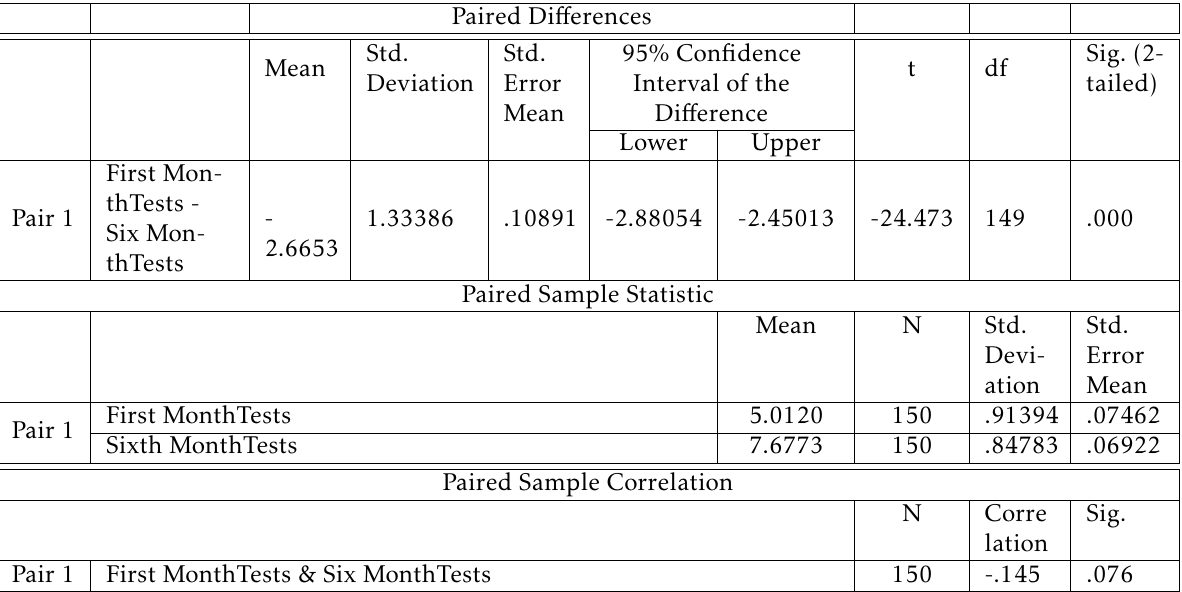
Table 5. Technology Acceptance Model (TAM) Based studentsâĂŹ satisfaction evaluation questionnaire TAM